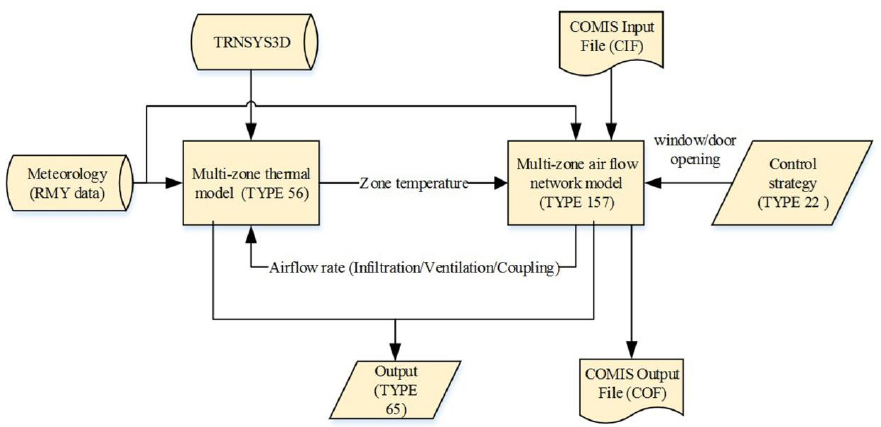
Figure 3. Integration of COMIS into TRNSYS simulation.